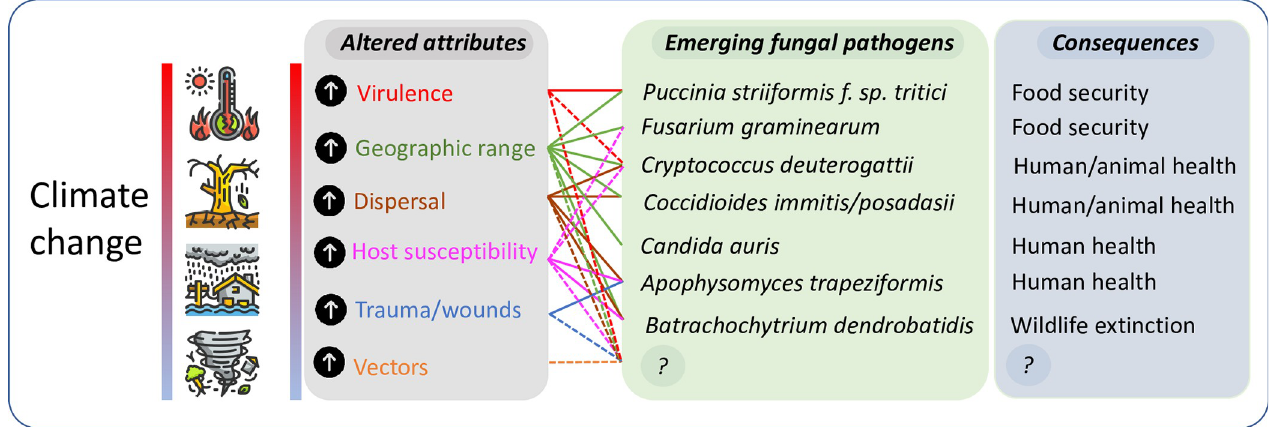
Fig 1. The effect of climate change on the emergence of fungal pathogens. Climate change alters attributes of the fungus, the environment, and the host, which can then drive the emergence of novel, uncommon, or adapted fungal species, with consequences for health, biodiversity, and food security. On this figure, solid lines between attributes and fungal species show links supported by published evidence; dashed lines show probable but unproven links. “?” represents the emergence of as-yet unknown fungal species and unknown consequences.